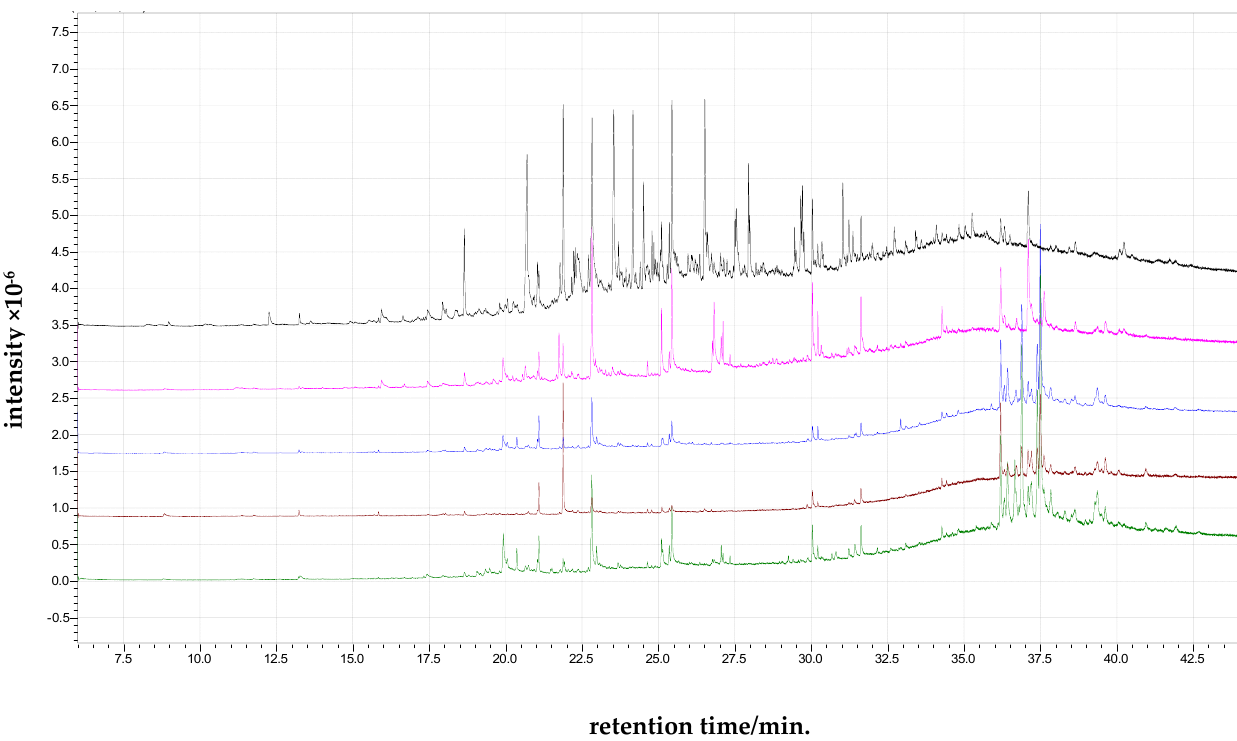
Figure 2. Raw chromatograms of individual poplar samples (black— P. alba L., pink— P. tremula L., blue— P. nigra L., brown— P. trichocarpa Torr. and A. Gray ex. Hook., green— P. maksimowiczi Henry.